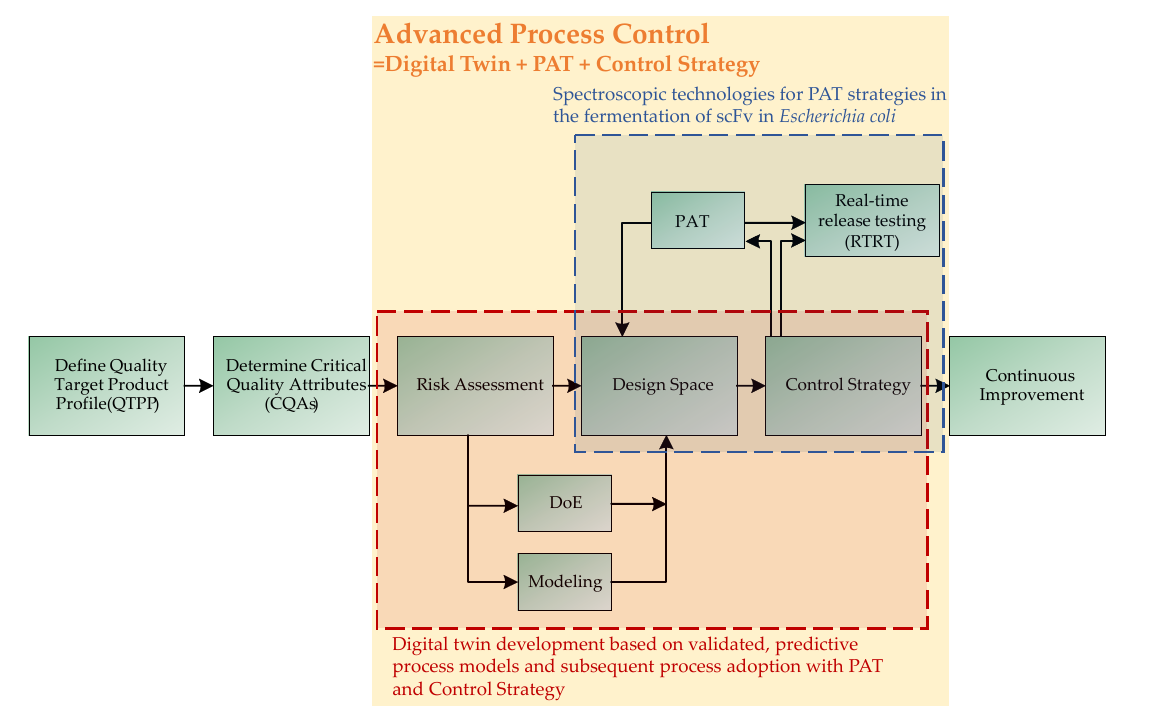
Digital twin development based on validated, predictive process models and subsequent process adoption with PAT and Control Figure 2. Workflow of model validation based on a QbD-oriented approach. In the first step, the QTPPs are defined. Subsequently, the CQAs are defined and a risk assessment of the influence of various process parameters on the CQAs is carried out. The risk assessment results in a design space for the process parameters to be investigated, which can be examined either via experiments or by means of a rigorous process model. Based on the results, a control strategy is defined, which can be continuously compared online via PAT with the actual state of the system. Strict implementation of this strategy allows continuous process optimization.